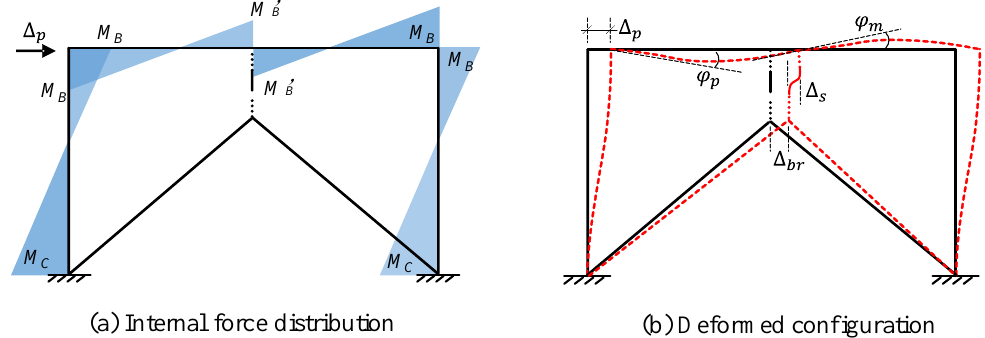
Figure 1. Theoretical model of structural mechanics.